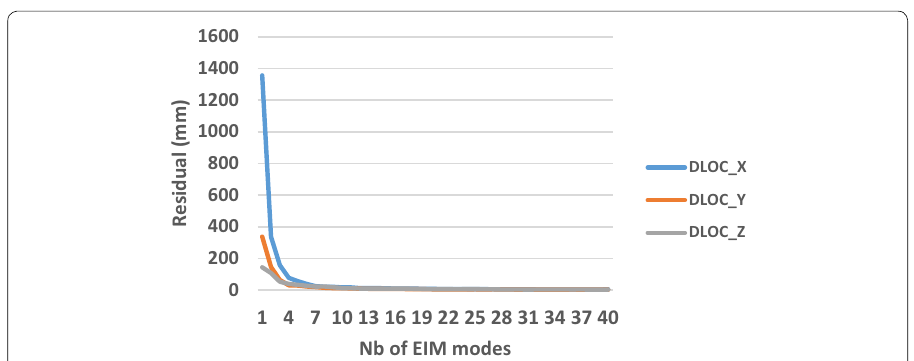
Fig. 4 Temporal evolution of the residual on three directions (408). DLOC refers to the local displacement field, on X, Y, and Z